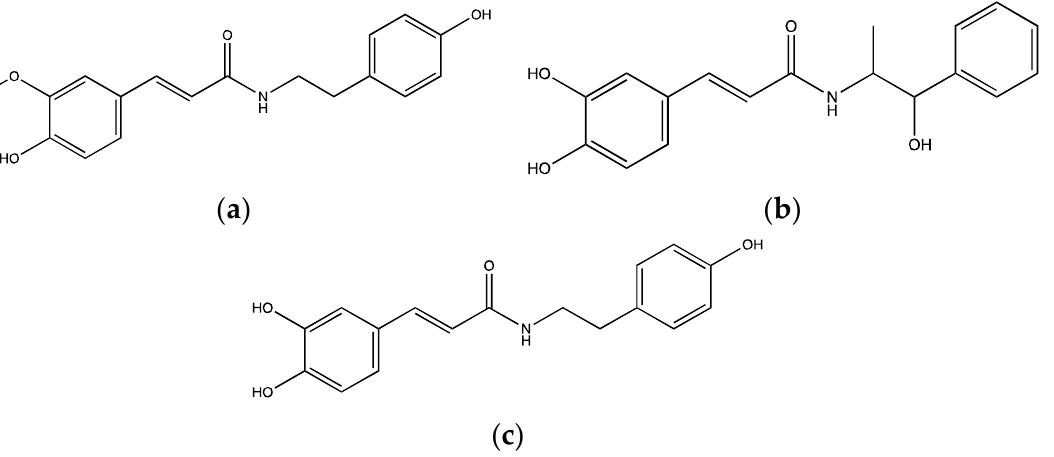
Figure 4. Chemical structures of ( a ) N -feruloyltyramine, ( b ) N -caffeoylnorephedrine and ( c ) N - caffeoyltyramine isolated from methanolic extracts of A. sativum .